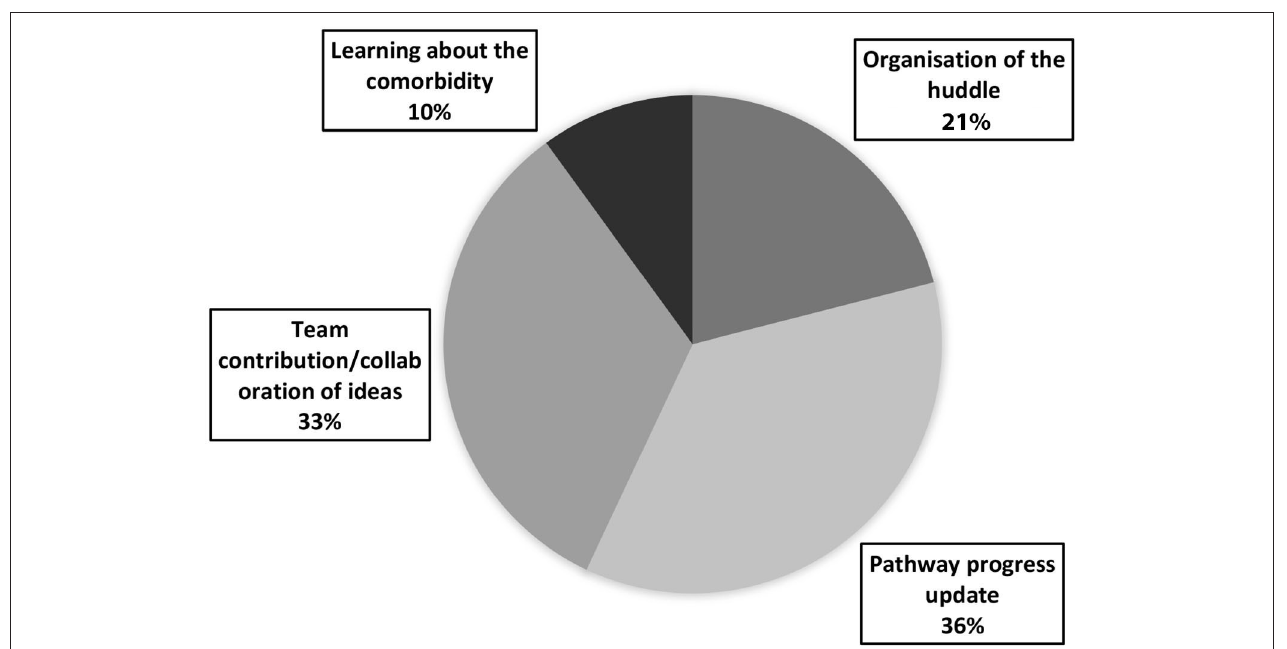
FIGURE 2 | A pie chart representing the overall themes of responses to question 2 “what went well?”.